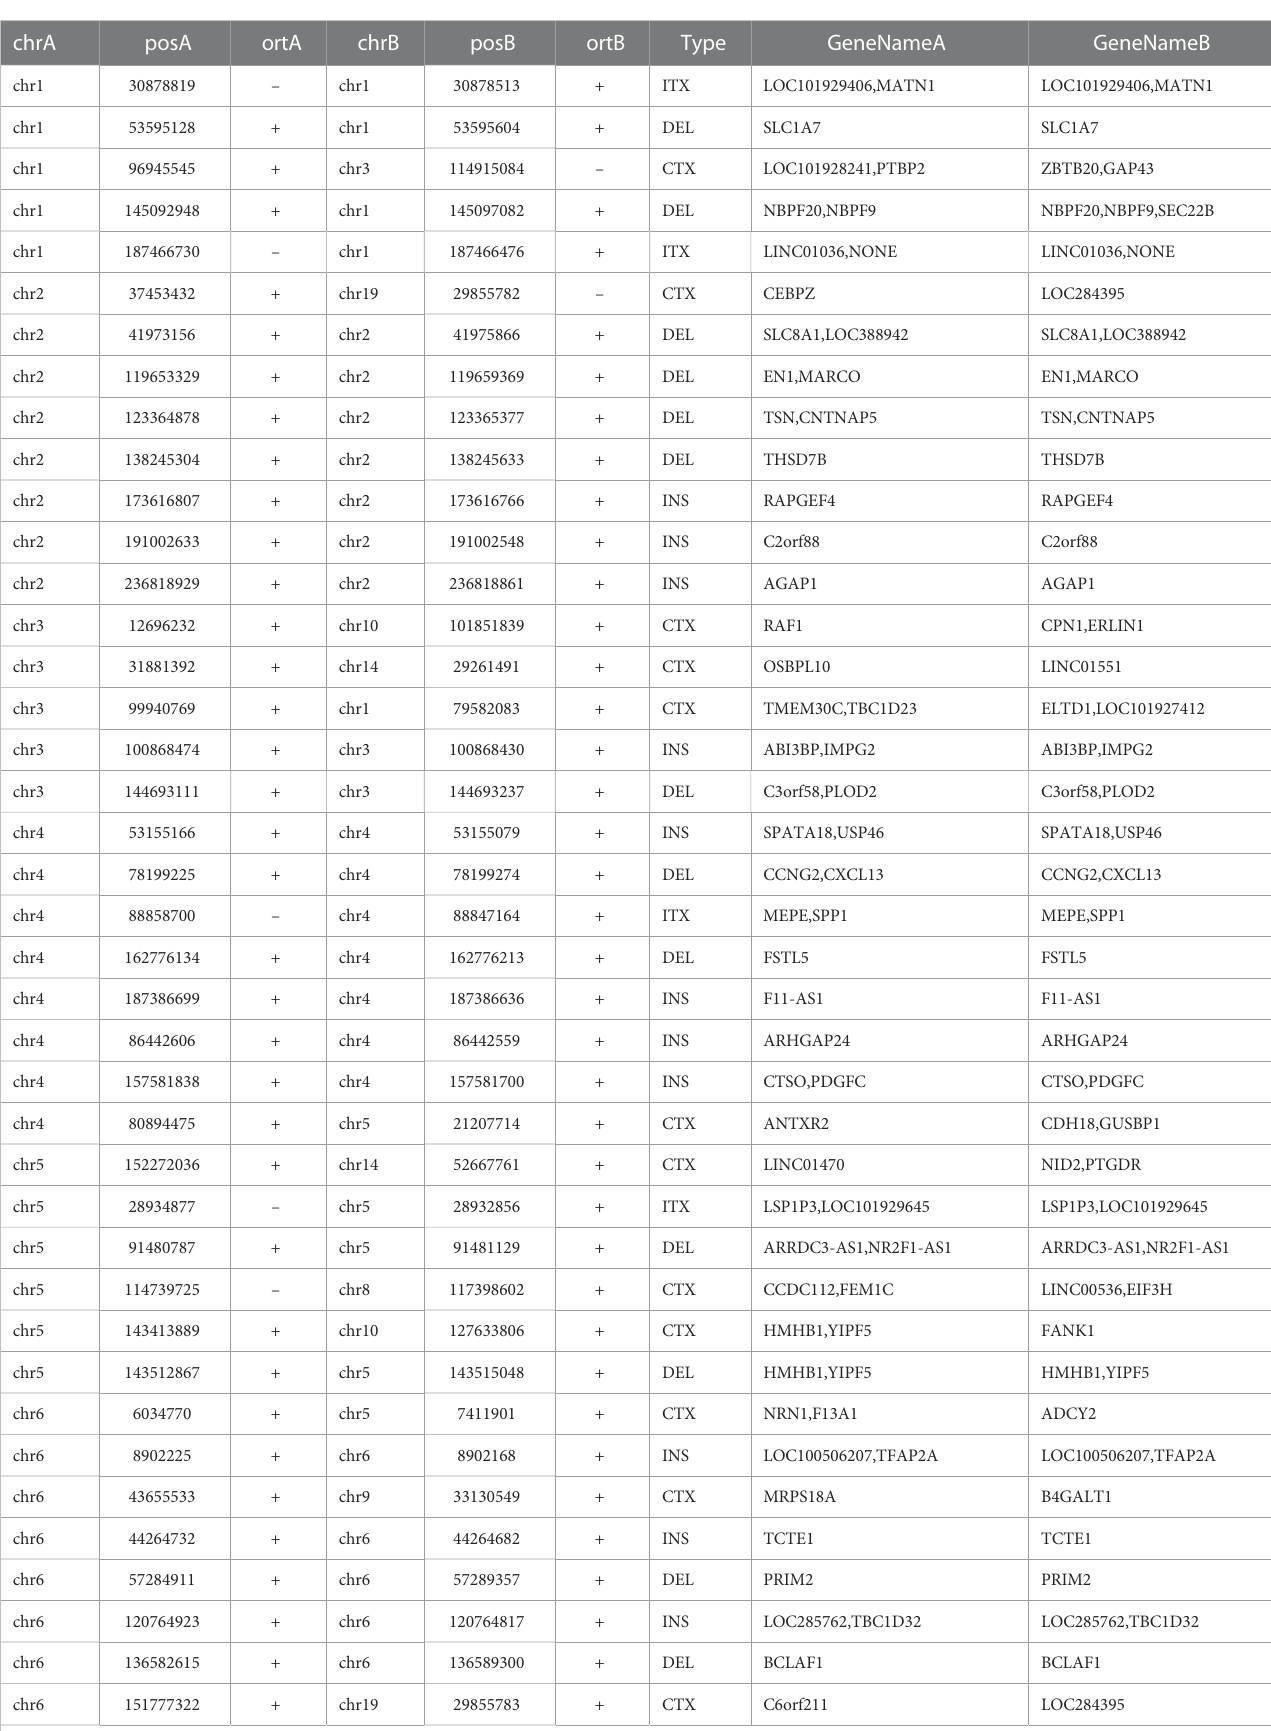
TABLE 2 Summary of common genes affected by